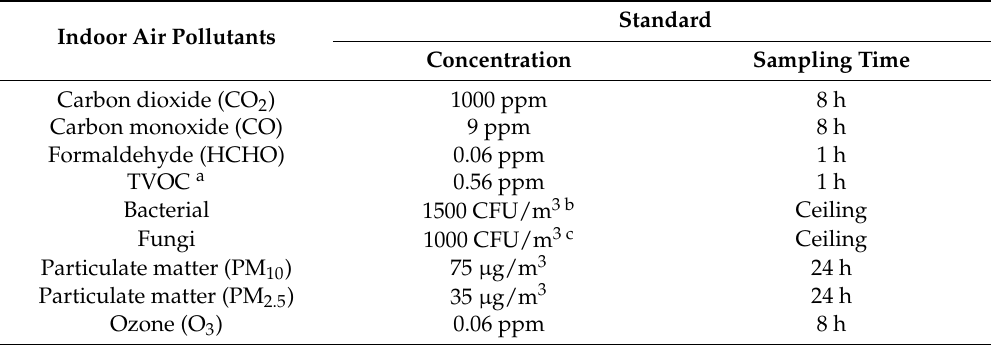
Table 1. Indoor air quality standards as compulsory guidelines in